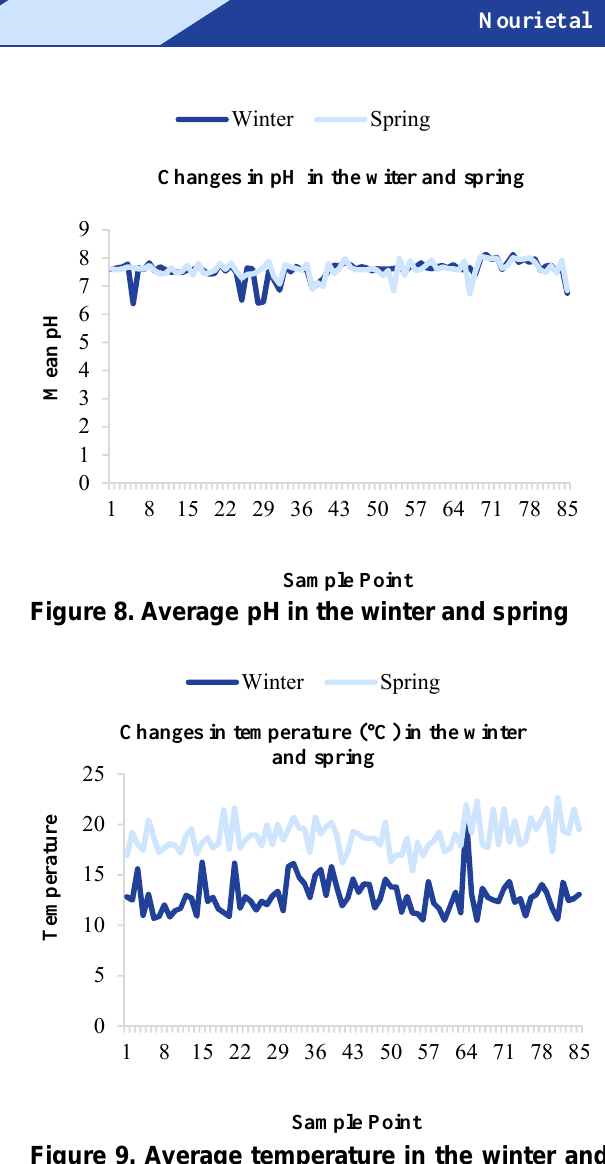
Figure 9. Average temperature in the winter and